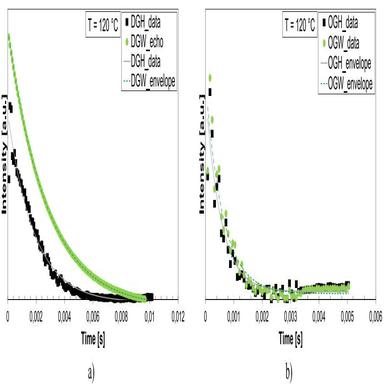
Experimental data and decay envelopes versus time: a) DGH and DGW, b) OGH and OGW.